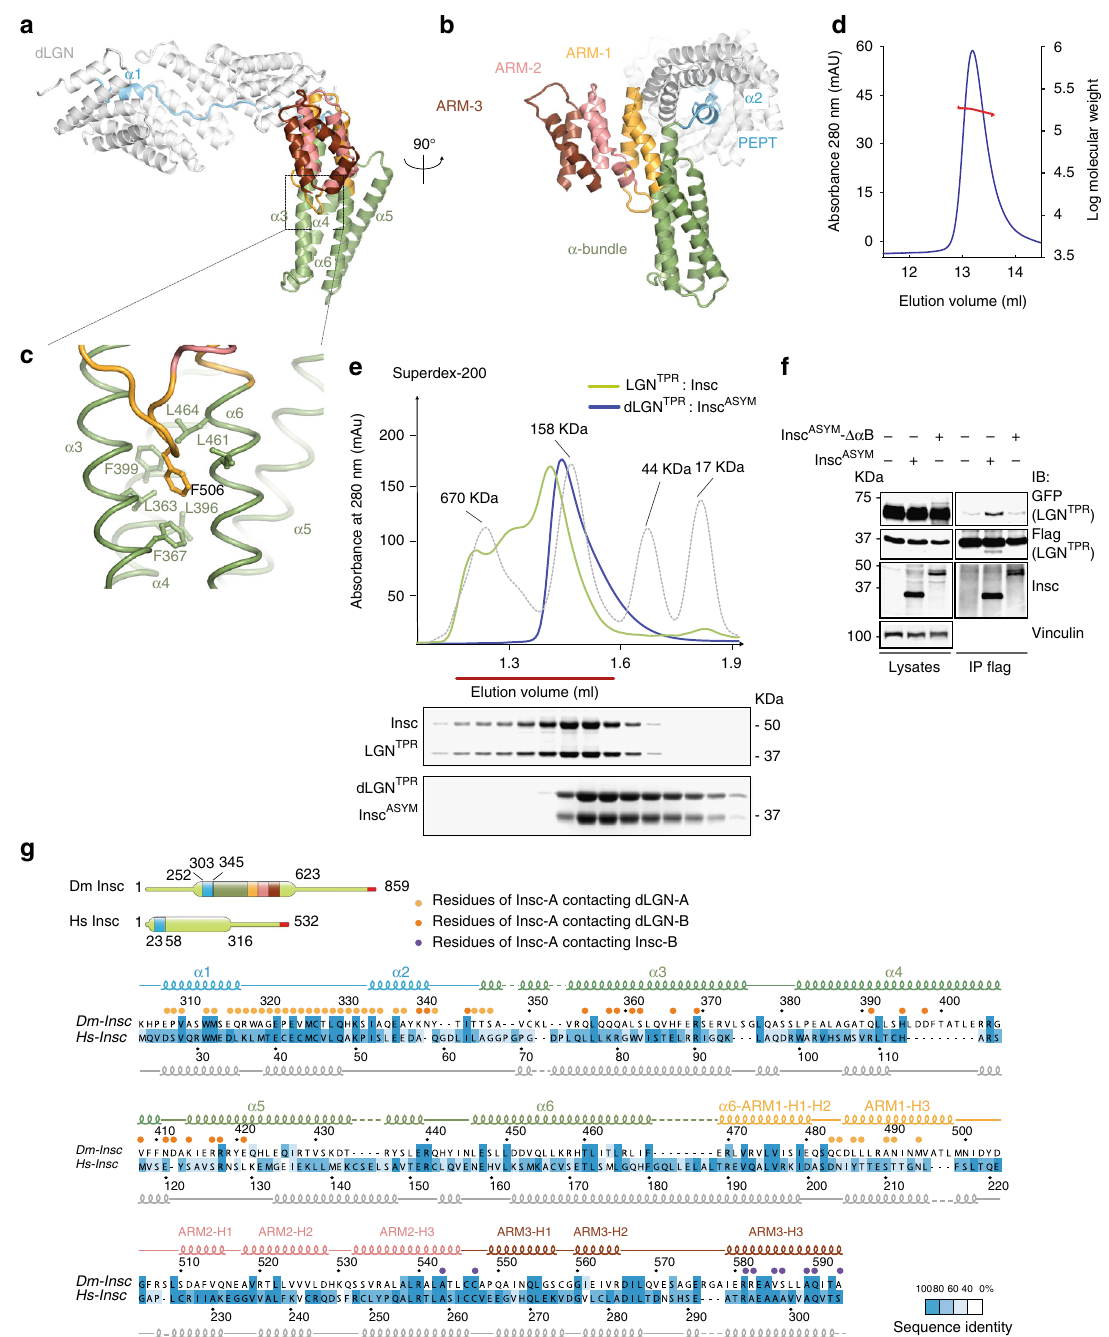
Fig. 3 The topology of the asymmetric domain of Insc is evolutionary conserved. a , b Cartoon model of Insc ASYM bound to the inner groove of dLGN TPR (in white) at two orthogonal views. After the initial Insc PEPT stretch (in cyan), the Insc chain departs from the TPR α -solenoid forming a four-helix bundle (green). The C-terminal part of the last helix of the bundle kinks into two short helical fragments of the fi rst non-canonical ARM repeat (gold), which is followed by two conventional ARM motifs adopting a triangular fl at shape (pink and brown). c Zoom of the hydrophobic pocket in which Phe506 Insc fi ts. d Static-Light-Scattering pro fi le of the dLGN TPR :Insc ASYM tetramer showing an average molecular mass of about 180 kDa along the peak, as expected for a 2:2 tetramer. e SEC elution pro fi les of Drosophila dLGN TPR :Insc ASYM (blue trace) and human LGN TPR :Insc (green trace) with associated Coomassie-stained SDS – PAGE separation of peak fractions. The elution pro fi le of globular markers is reported in a dashed gray line. Both complexes elute in fractions consistent with the theoretical molecular mass of 2:2 tetramers. f Insc ASYM - Δα B assembles with LGN TPR in a 1:1 stoichiometry. HEK293T cells were transiently transfected with plasmids containing human GFP-LGN TPR and FLAG-LGN TPR (residues 1 – 350) alone or in combination with human Insc ASYM or Insc ASYM - Δα B (lacking residues 62 – 191). After 48 h, cells lysates were immunoprecipitated (IPs) with anti-FLAG antibodies conjugated to sepharose beads, and immunoblotted (IB) with the indicated antibodies. FLAG-LGN TPR - was able to co-immunoprecipitate with GFP-LGN TPR only when bound to Insc ASYM , but not to Insc ASYM - Δα B. g Sequence alignment of Insc ASYM with secondary structure elements based on the crystallographic structure (for Drosophila ) and in silico prediction (for Homo sapiens ). Residues are colored according to the degree of conservation calculated on the basis of the alignment of Supplementary Fig. 4. Circles indicate residues of Insc ASYM in contact with the other three subunits of the tetramer NATURE COMMUNICATIONS | (2018)